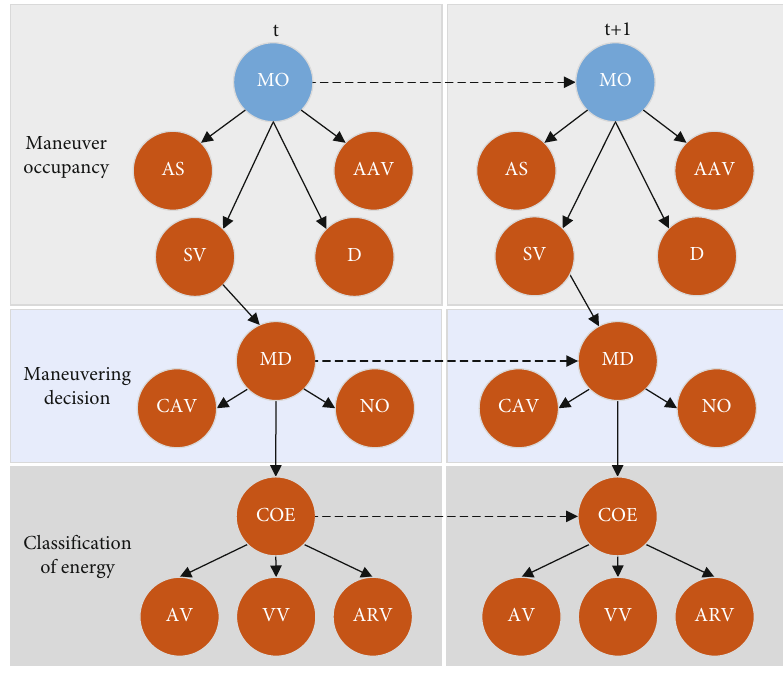
Figure 4: DBN model of mobile occupancy feature